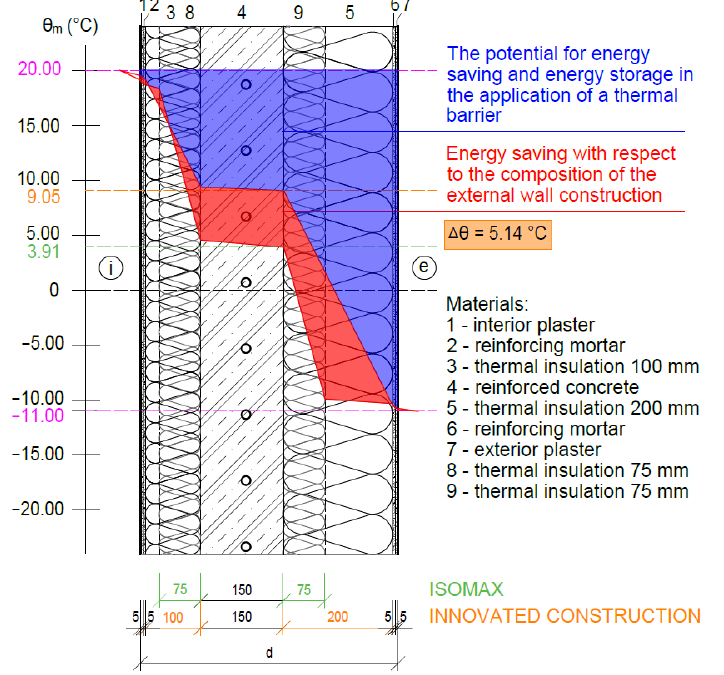
Figure 15. Energy saving and energy storage potential of thermal barrier application for both variants